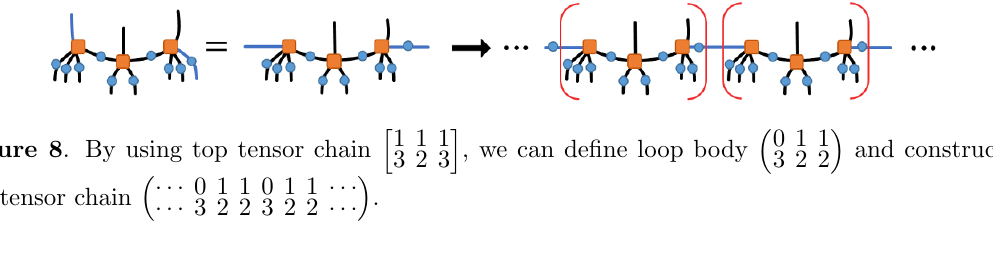
(cid:16) (cid:1) (cid:1) (cid:1) 0 1 1 0 1 1 (cid:1) (cid:1) (cid:1) (cid:1) (cid:1) (cid:1) 3 2 2 3 2 2 (cid:1) (cid:1) (cid:1)